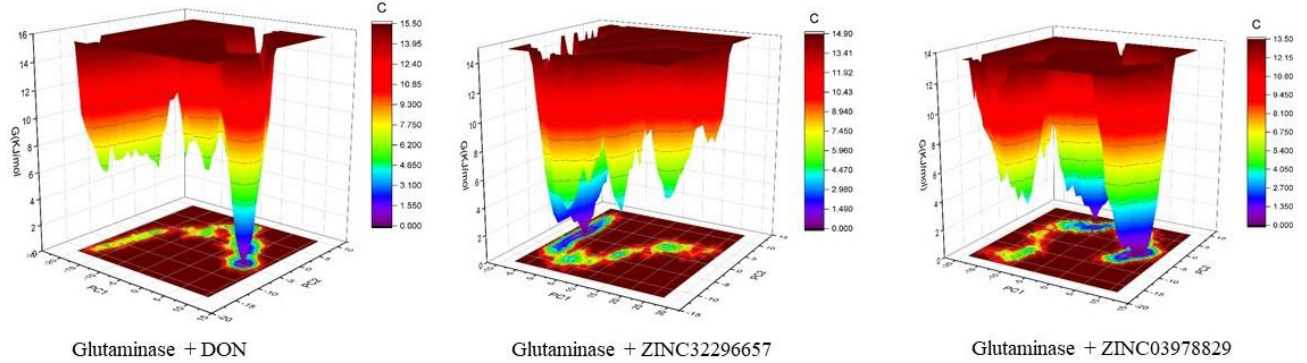
Figure 6. Gibbs free energy landscape of the complexes with GLS.